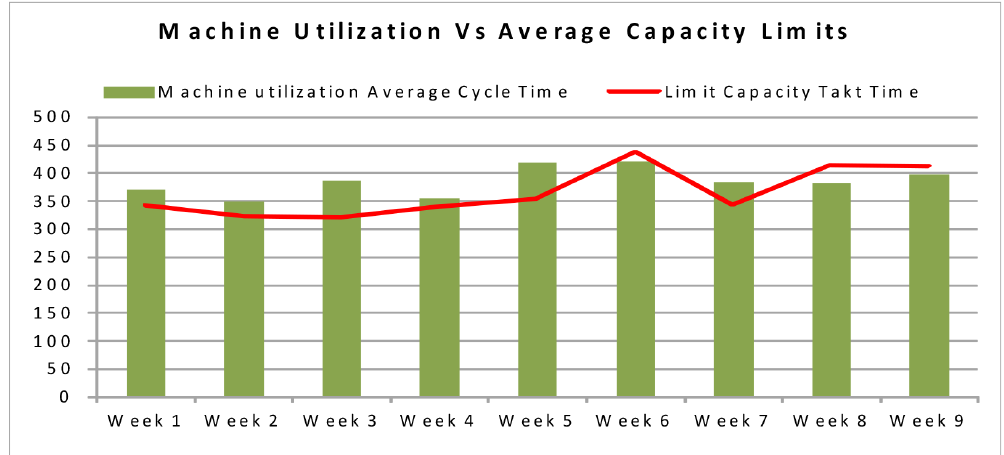
Figure 3. Comparison of workload and capacity allowable using performance